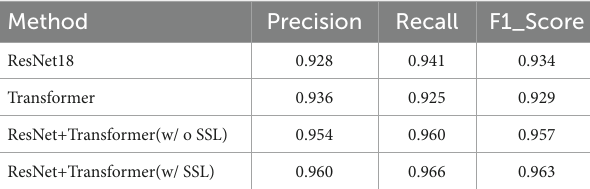
TABLE 2 Results of pulmonary fibrosis degree classification.